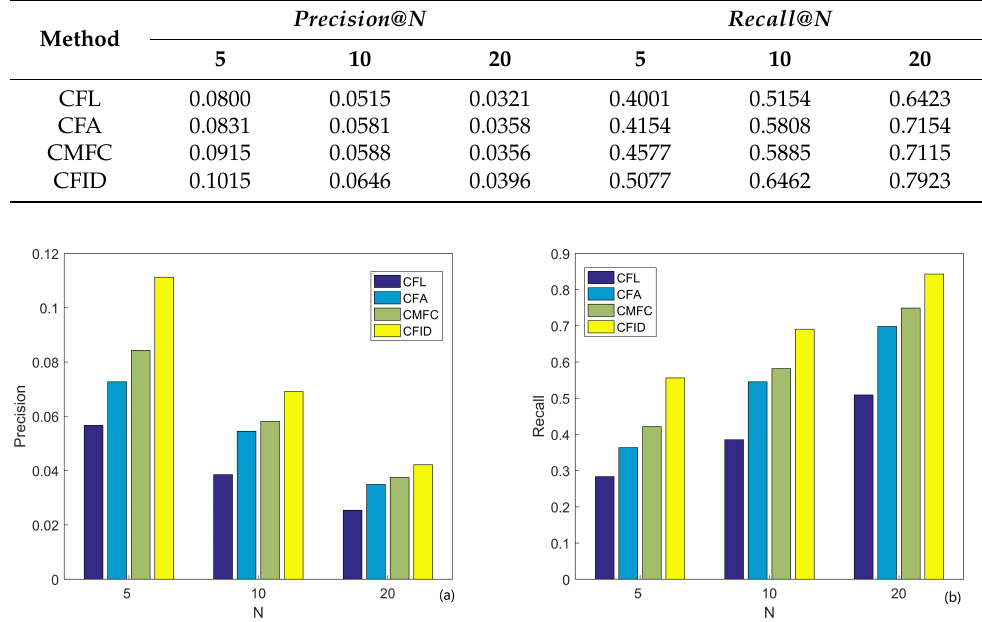
Figure 7. Multi-person group recommendation results of four algorithms on New York City dataset. ( a ) precision result; ( b ) recall result.